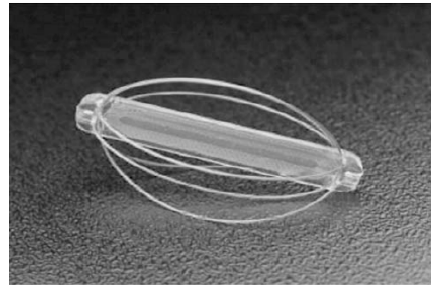
Figure 2. EndoSure pressure sensor (CardioMems).